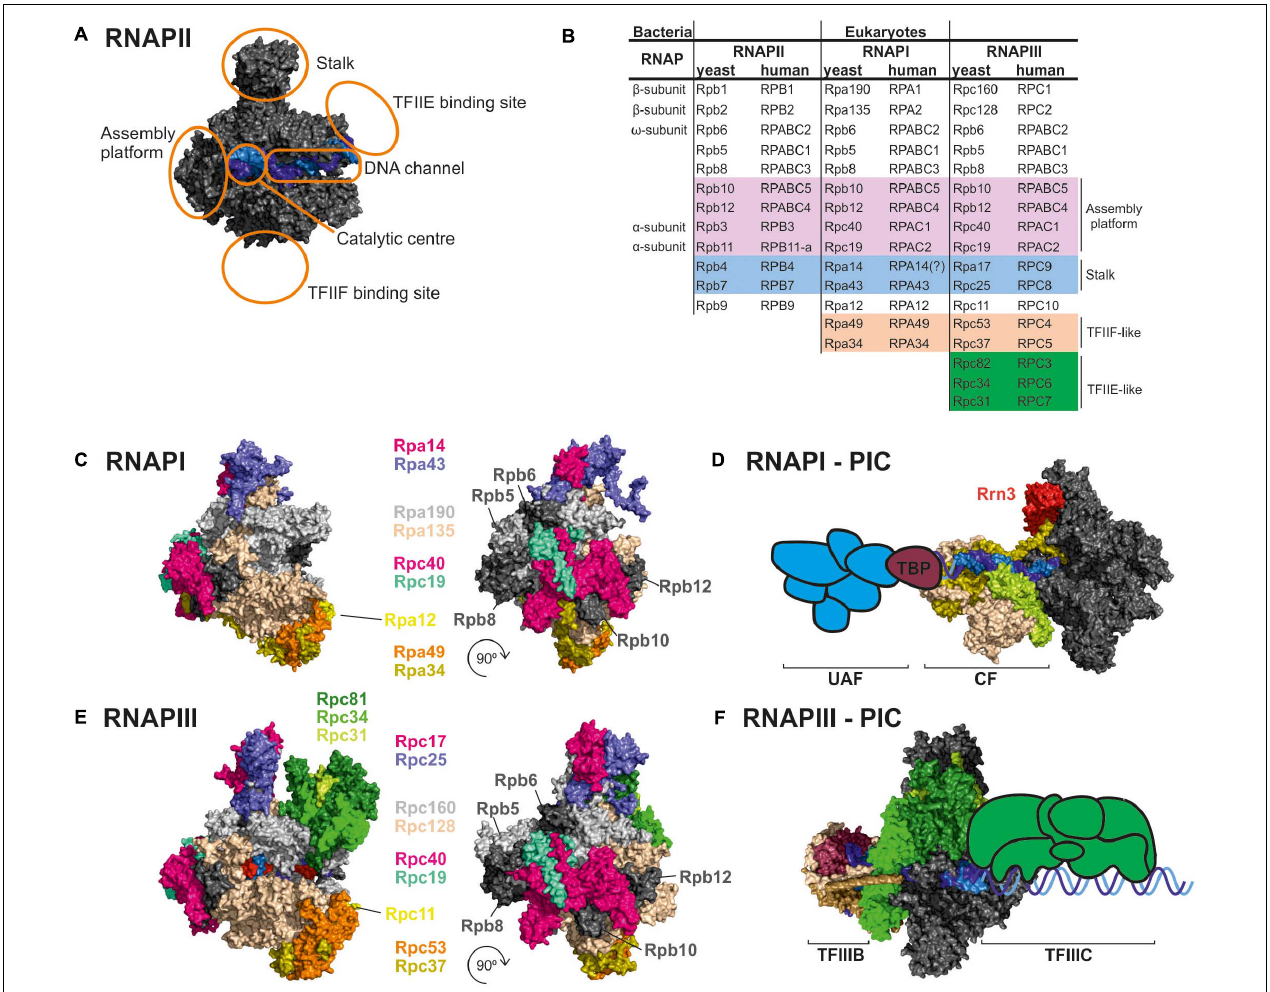
FIGURE 1 | Comparison of RNAPI and RNAPIII structures and transcription factors. (A) General architecture of RNAPII, consisting of the catalytic core and stalk. RNAPII core consists of a DNA binding channel, catalytic center, and assembly platform. RNAPII binds multiple transcription factors (TFs). Some TFs are homologous to additional subunits of specialized RNAPs (i.e., TFIIF). (B) Subunit composition of eukaryotic RNAPs. Human nomenclature is shown for comparision. Please note that C-terminal region of Rpa49 subunit harbors a “tandem winged helix” which is predicted in TFIIE and that human RNAPIII RPC7 subunit is coded by two isoforms α and β . The question mark indicates name unconfirmed. (C) Subunit composition of yeast RNAPI. (D) Model of the RNAPI pre-initiation complex, showing an early intermediate with visible Rrn3 and core factor (CF). TATA-binding protein (TBP) and upstream-associated factor (UAF) are added schematically. (E) Subunit composition of yeast RNAPIII. (F) Atomic model of RNAPIII pre-initiation complex with TFIIIB. The Rpc82/34/31 heterotrimer is involved in initiation and marked in green as in E. TFIIIC is added schematically. PDB: 5C4X, 5FJ8, 4C3J, 6EU0, and 6TPS (Fernández-Tornero et al., 2013; Barnes et al., 2015;